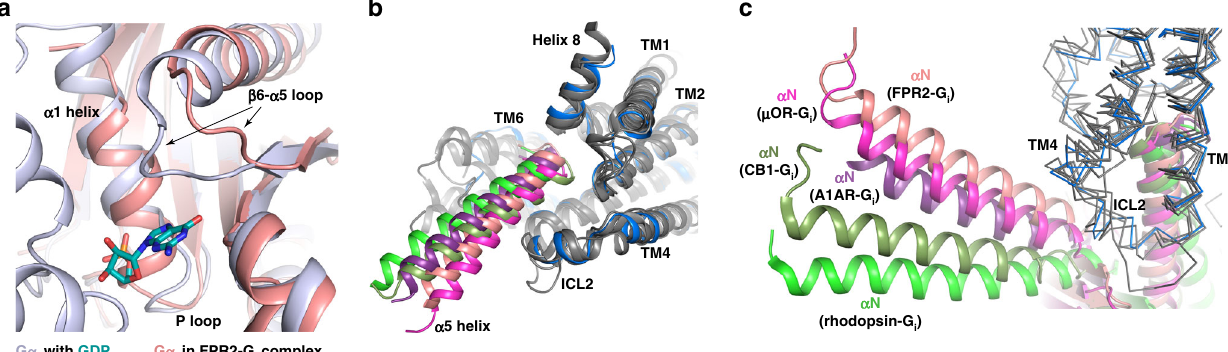
Fig. 7 G i protein in different structures. a Structural comparison of G α i in the FPR2-G i complex and GDP-bound G α i (PDB ID 1GP2). G i in the FPR2-G i complex is colored in salmon. G i in the GDP-bound structure is colored in light blue. GDP is shown as green cyan sticks. b , c Structural comparison of α 5 ( b ) and α N ( c ) of G α i in different structures. G α i is colored in salmon in FPR2-G i , magenta in μ OR-G i , purple in A1AR-G i , dark green in CB1-G i and green in rhodopsin-G i . The structural alignment is based on the receptors. FPR2 is colored in blue. All other receptors are colored in dark